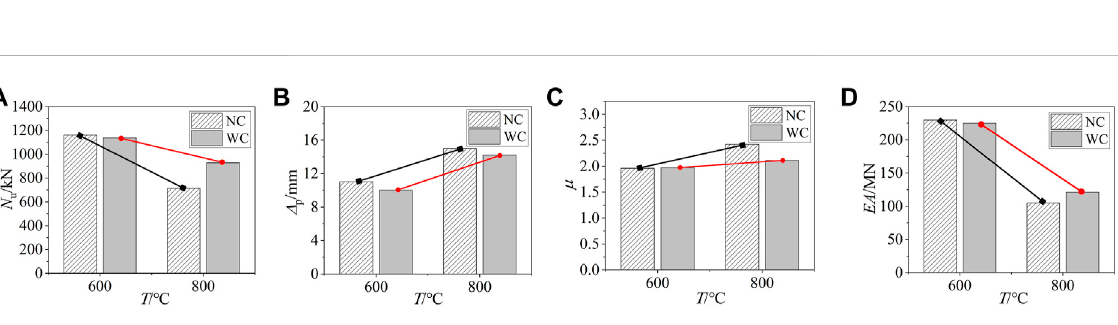
FIGURE 12 In fl uence of different cooling methods on mechanical properties. (A) peak load; (B) peak displacement (C) initial stiffness (D) displacement ductility coef fi